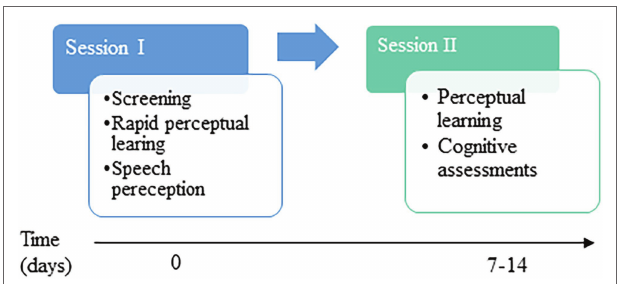
FIGURE 2 | Schematic illustration of study